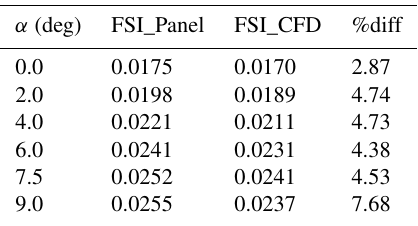
Table 5. Comparison of displacement (m) in y direction for differ- ent angles of